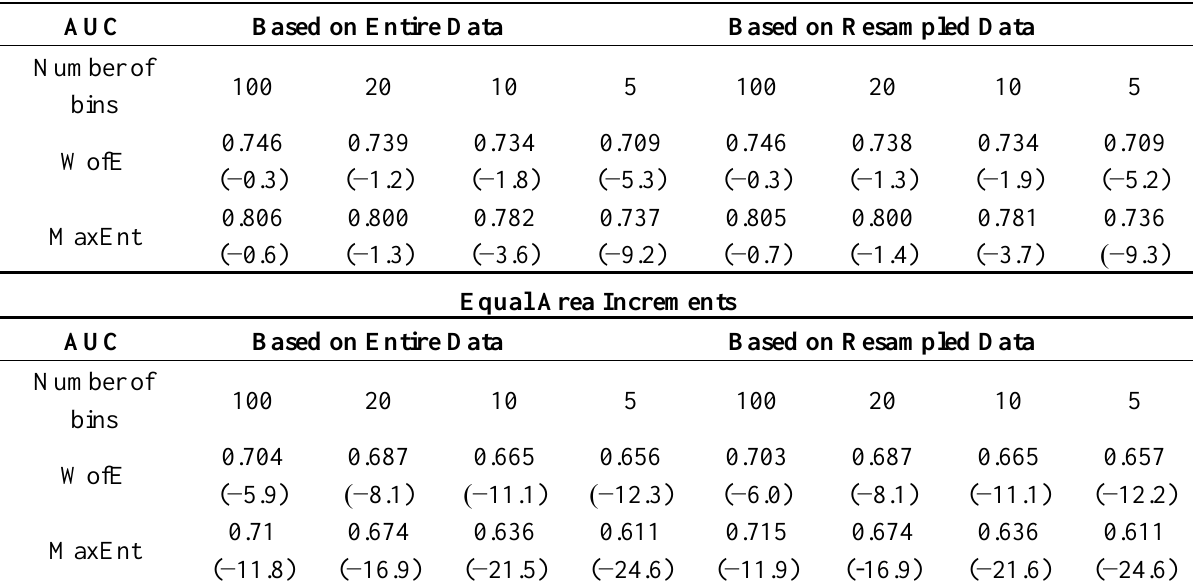
Table 2. AUC values obtained using various thresholds increments and slicing methods on entire and resampled data. Exact values of AUC are 0.7478 and 0.8110 for WofE and MaxEnt respectively. Number between parentheses is the estimate’s error expressed as the relative difference between the value and the exact value (in % of the exact value).